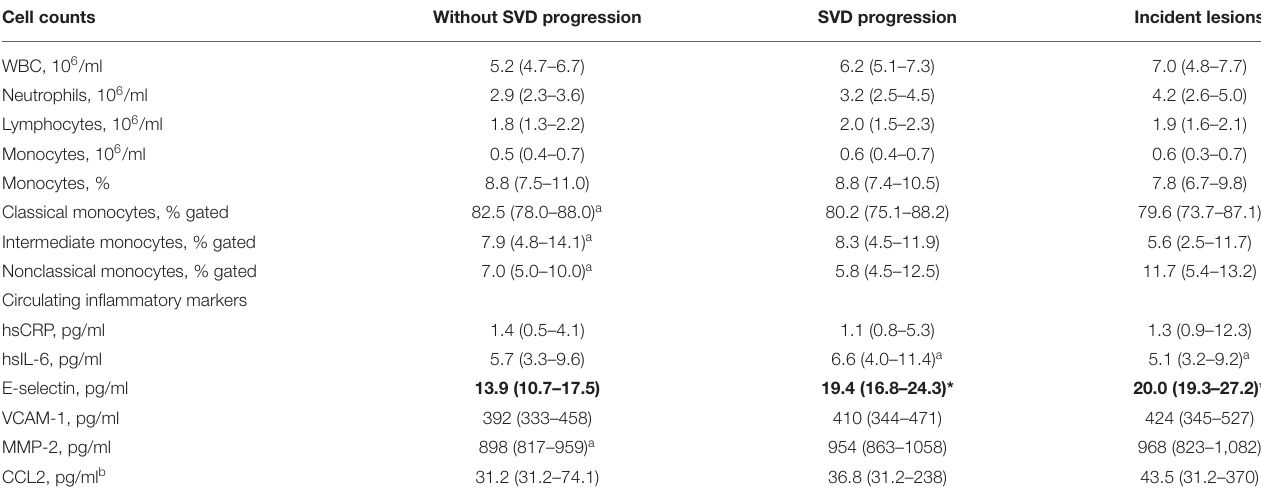
TABLE 2 | Circulating cells and inflammatory